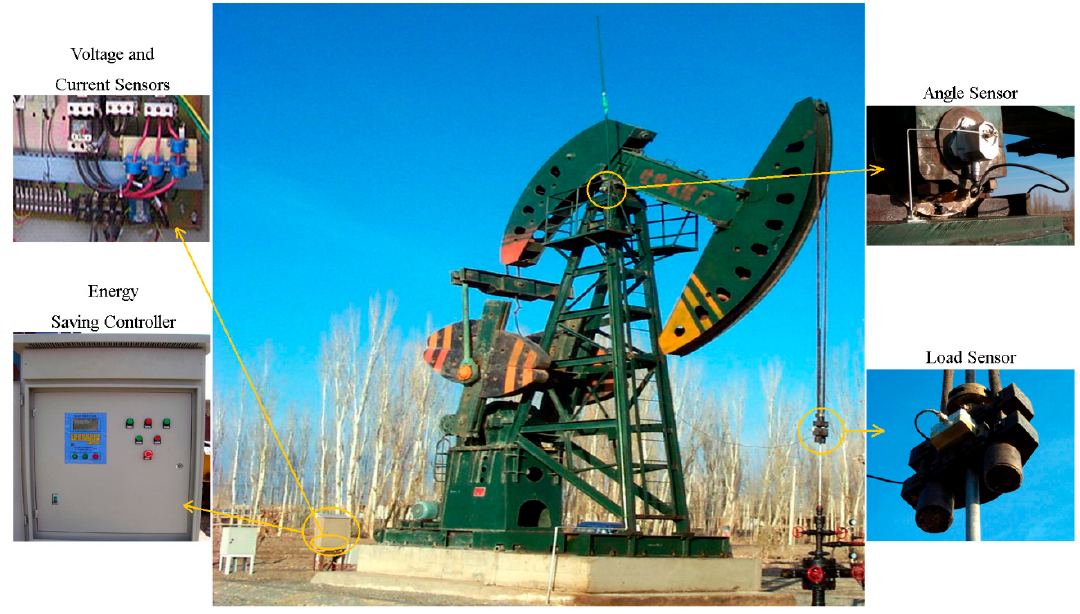
Figure 5. The energy saving device installed on a beam pumping unit, with the actual assembled positions for the four types of sensors and the controller.